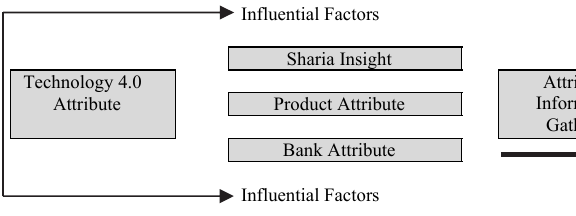
Fig. 2. Conceptual Framework Consumer Decision-Making Process Source: Adapted from (Kontot, Hamali, and Abdullah